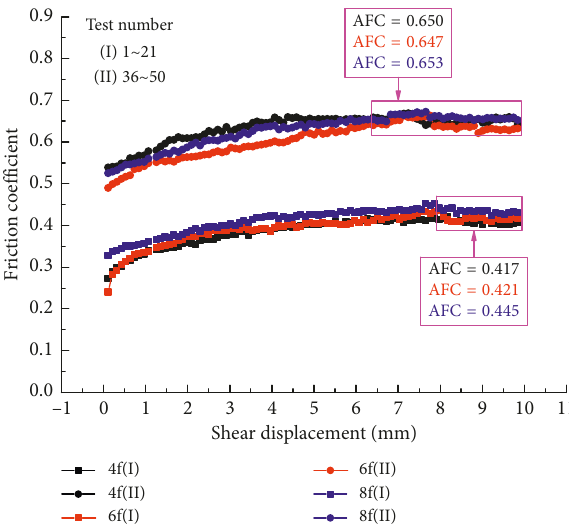
Figure 13: Direct shear testing results under a mixture of waste and bentonite slurries.